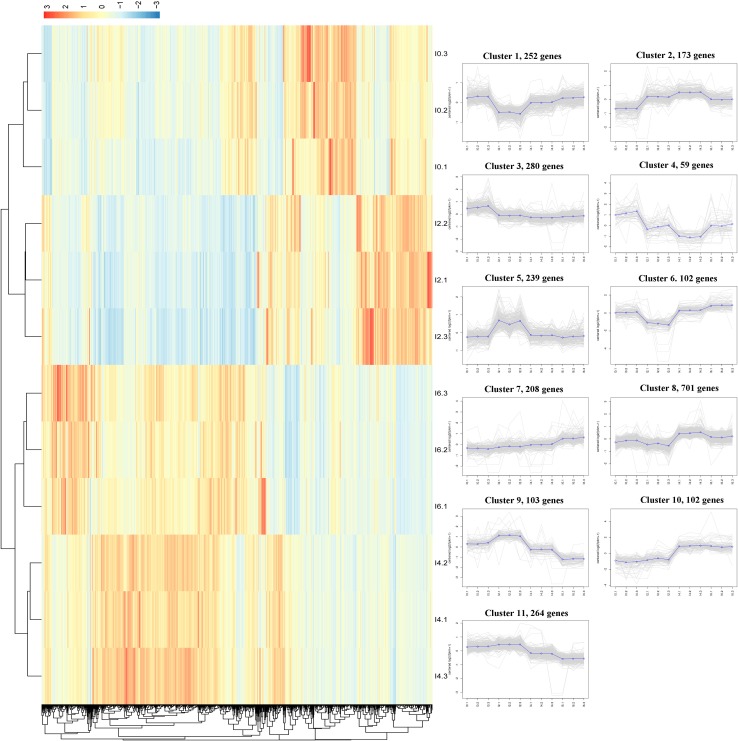
Clustering of all DEGs (lncRNAs and mRNAs).The heatmap shows the K-means clustering of transformed expression values for lncRNAs and mRNAs. Yellow represents higher expression and blue represents lower expression. The line charts represent the expression patterns of genes in 11 clusters corresponding to the heatmap.